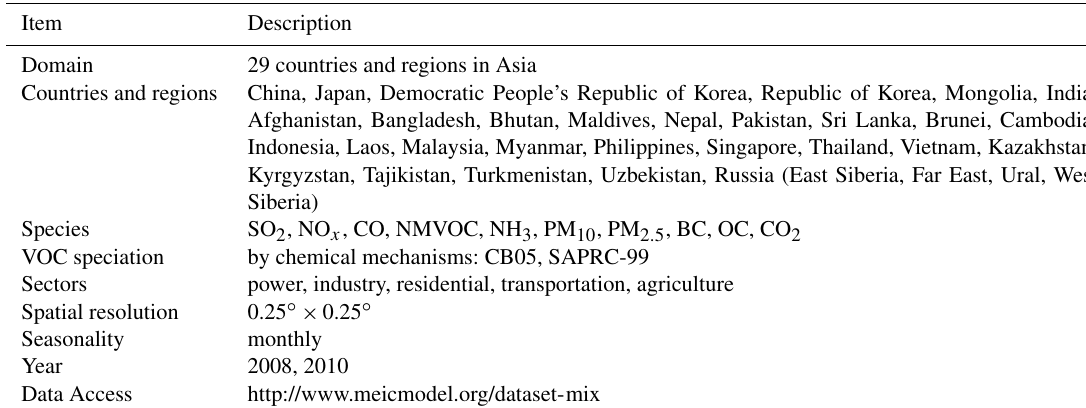
Table 1. Summary of the MIX Asian anthropogenic emission inventory. Item